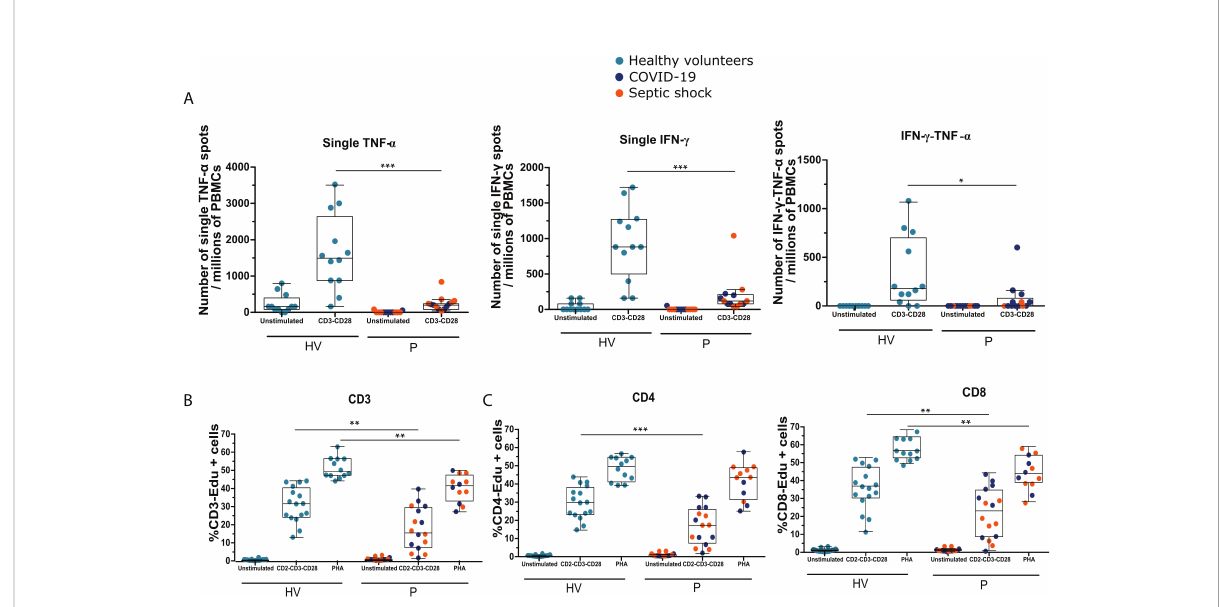
FIGURE 2 Patients with septic shock and COVID-19 in ICU are immunosuppressed and share T lymphocyte dysfunctions. The cytokine production and proliferation capacities of immune cells from patients (P) with septic shock and COVID-19 collected 3 or 4 days following ICU admission as well as and healthy volunteers (HVs) were analyzed using functional assays. (A) Numbers of single – TNF- a , single – IFN- g , and double – IFN- g – TNF- a spots per millions of PBMCs produced following overnight stimulation with anti-CD3 and anti-CD28 antibodies measured by ELISpot assay using PBMCs of patients with septic shock (n = 7) and COVID-19 (n = 6) or HVs (n =12). (B) Percentages of Edu+ CD3+ T cells following 3 days of PBMCs culture with anti – CD2-CD3-CD28 antibody – coated beads or phytohemagglutinin (PHA) at 4 m g/ml measured by fl ow cytometry in septic shock (n = 7) and COVID-19 (n = 9) patients or HVs (n = 16). (C) Percentages of Edu+ CD4+ or Edu+ CD8+ cells following 3 days of PBMCs culture with anti – CD2-CD3-CD28 antibody – coated beads (ratio 1:1) measured by fl ow cytometry in patients with septic shock (n = 7) and COVID-19 (n = 9) and HVs (n = 16). Data are represented as Tukey box plot. The non-parametric Mann – Whitney test was performed to compare HVs and patients. * p < 0.05, ** p < 0.01, and *** p <